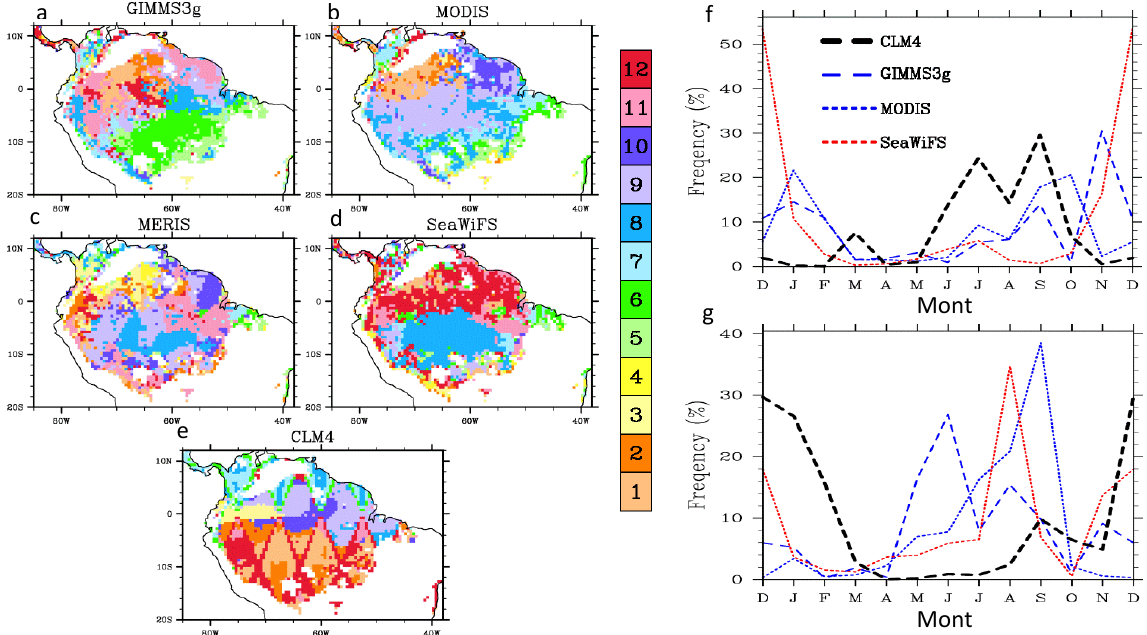
Figure 9. Month of maximum FPAR in the Amazon from ( a ) GIMMS3g, ( b ) MODIS, ( c ) MERIS, ( d ) SeaWiFS, and ( e ) CLM4 simulation. Probability density function of maximum FPAR months in the northern ( f ) and southern ( g ) parts of the Amazon, divided by the